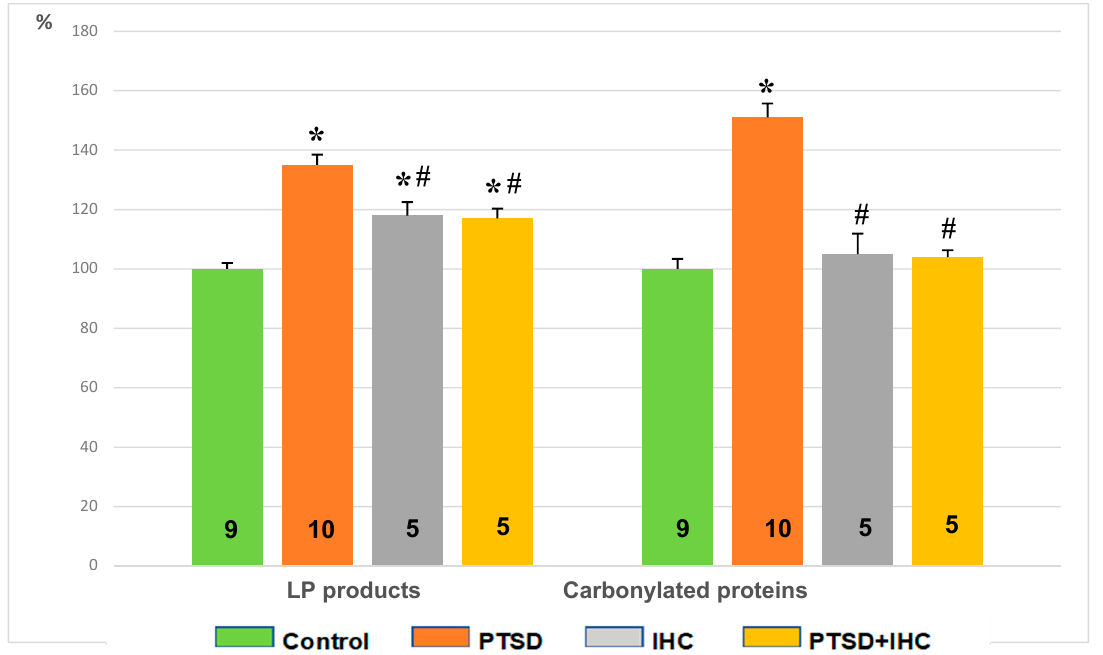
Figure 4. Effects of PTSD, IHC, and PTSD+IHC on concentrations of oxidative stress markers in the rat myocardium. PTSD = posttraumatic stress disorder; IHC = intermittent hypoxic conditioning; LP = lipid peroxidation. Data are presented as means ± SEM in percent of control values (for control, LP products = 0.396 ± 0.024 oxidation conventional units; carbonylated proteins = 408 ± 42 oxidation conventional units). Numbers of rats in the groups are shown on the bars. * Significantly different from control; # significantly different from PTSD. Specific p values are stated in the text.